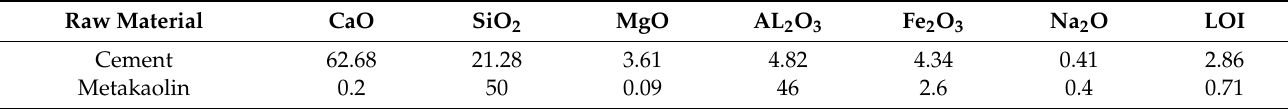
Table 1. The chemical composition of raw materials kg/m 3